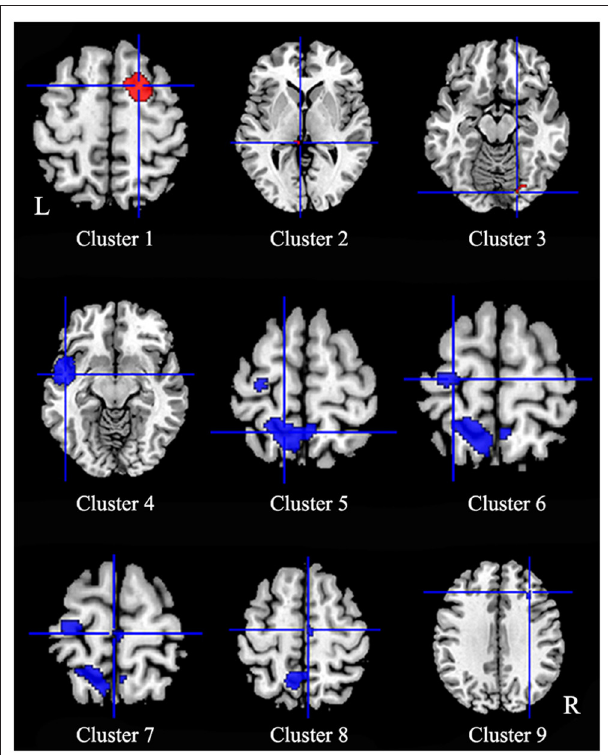
FIGURE 3 | Regions of functional alterations in patients with idiopathic blepharospasm compared with healthy controls. Patients with iBSP showed increased activity compared to healthy controls in the right dorsolateral superior frontal gyrus (Cluster 1), left thalamus (Cluster 2) and right fusiform gyrus (Cluster 3), while decreased activity in left temporal pole and left insula (Cluster 4), left precentral gyrus (Cluster 6), bilateral precuneus (Cluster 5) and paracentral lobules (Cluster 7), left superior parietal gyrus, right SMA (Cluster 8), and middle frontal gyrus (Cluster 9).